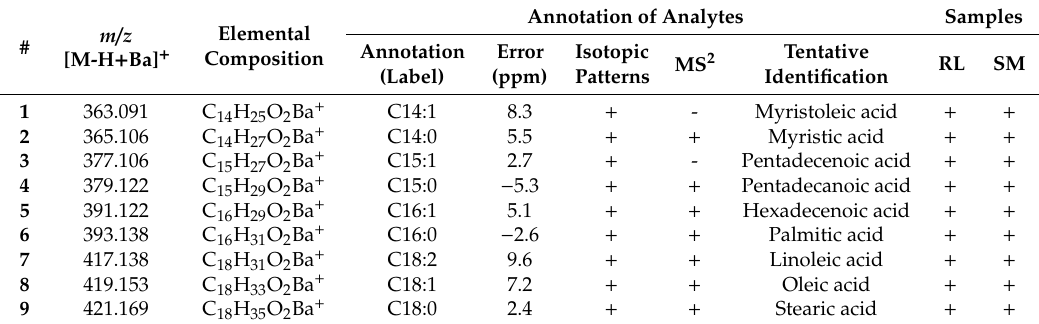
Table 1. Annotation of free fatty acids (FFAs) in n -hexane extracts of aqueous and hexane lysates of